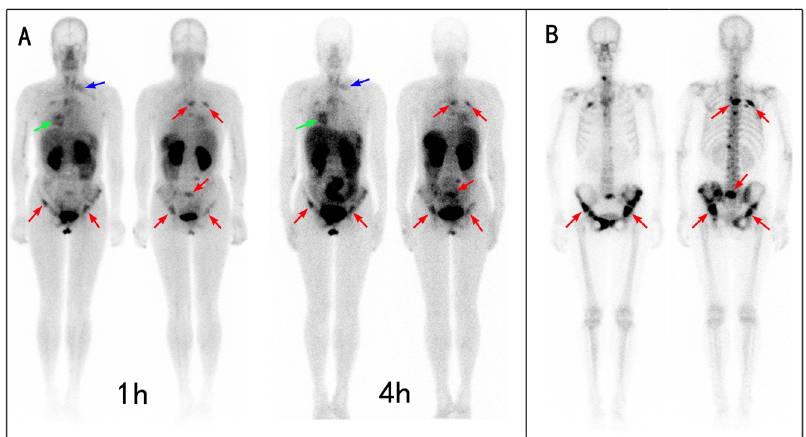
Figure 3. Comparison of 99m Tc-3PRGD2 integrin receptor imaging with 99m Tc-MDP bone scan in a patient with multiple bone metastases. A: The 99m Tc-3PRGD2 imaging showed the lung cancer (green arrow), lymph node metastases (blue arrow), and bone metastases (red arrow) at the same time. The 1-h imaging is better than the 4-h imaging because of the relatively lower background in bone marrow, liver, and spleen. B. 99m Tc-MDP bone scan demonstrated better contrast, facilitating the detection of small bone lesions. However, 99m Tc-MDP accumulated for the bone repair with limited specificity, whereas 99m Tc-3PRGD2 targeted the metastatic tumor directly.